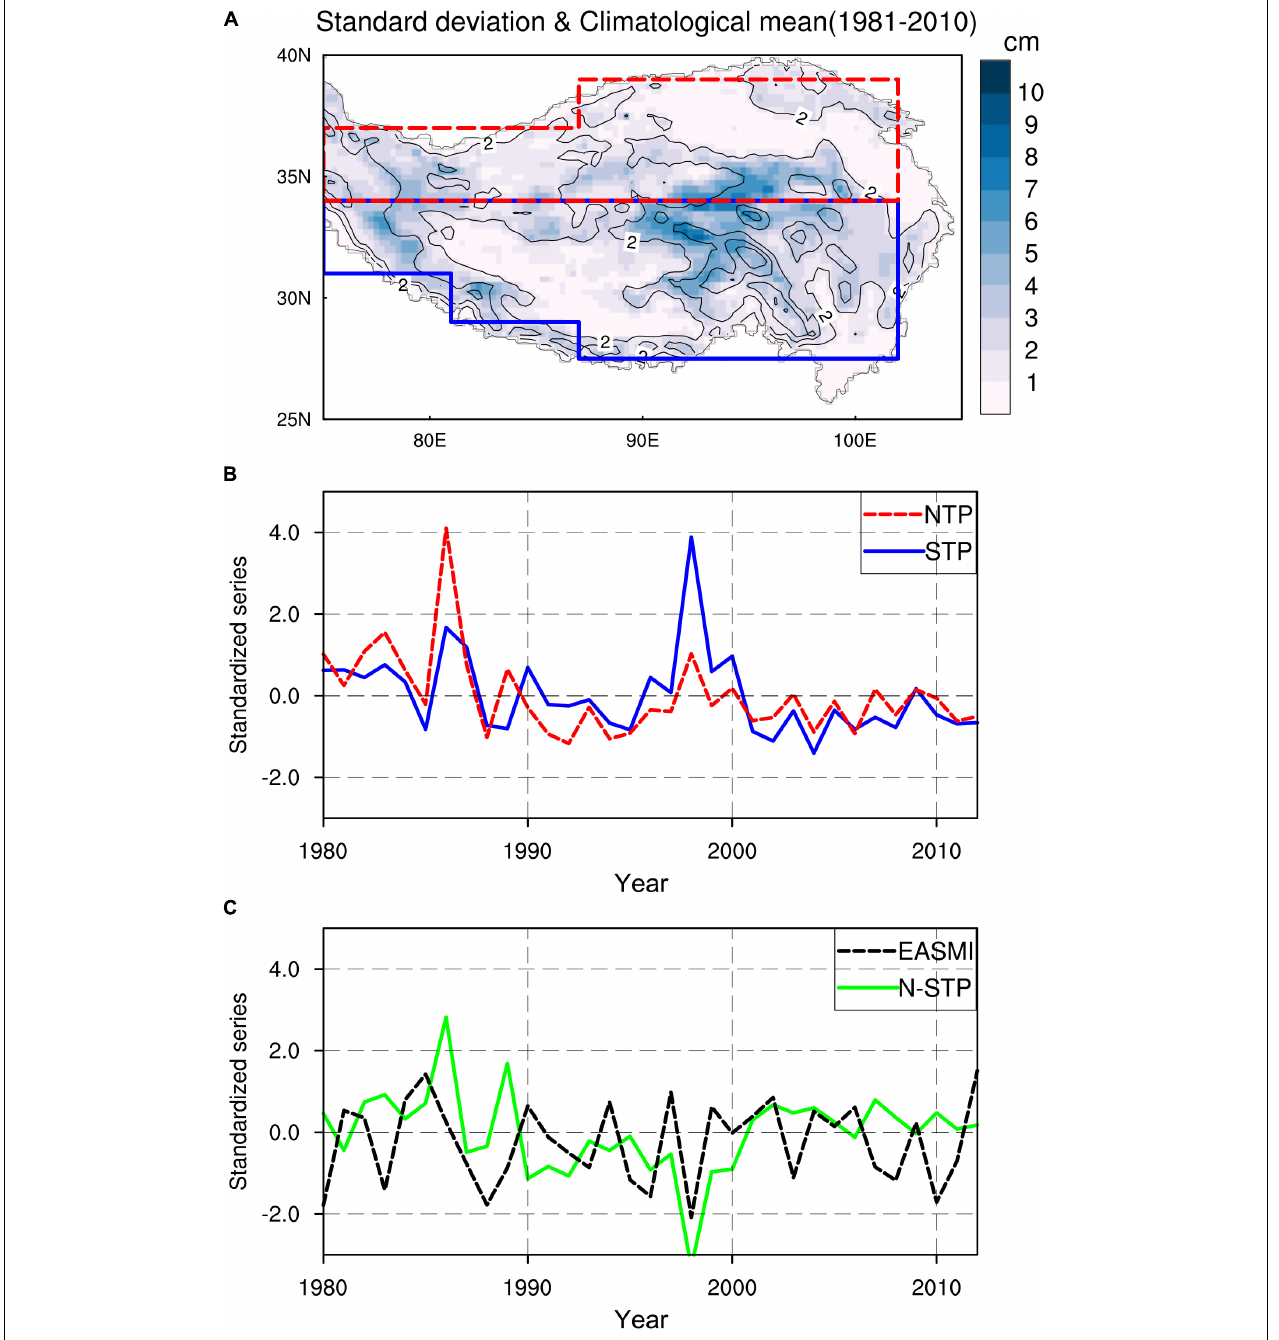
FIGURE 6 | (A) Distribution of stand deviation (color) and climatological mean (1981–2010; contour, interval is 4 cm) of snow depth over the Tibetan Plateau (TP) in the cold season (defined as the duration from November to April in the next year), regions surrounded by the blue dashed lines and red solid lines indicate the southern TP (STP) and northern TP (NTP), respectively. (B) Evaluations of standardized series of snow depth averaged over STP and NTP. (C) Evaluations of standardized series of snow depth differences between STP and NTP (N-STP) and East Asian summer monsoon index (EASMI) [defined by Li and Zeng (2001)]. The snow depth dataset is derived from SMMR, SSM/I, and AMSR-E passive microwave remote sensing data (Che et al., 2008).